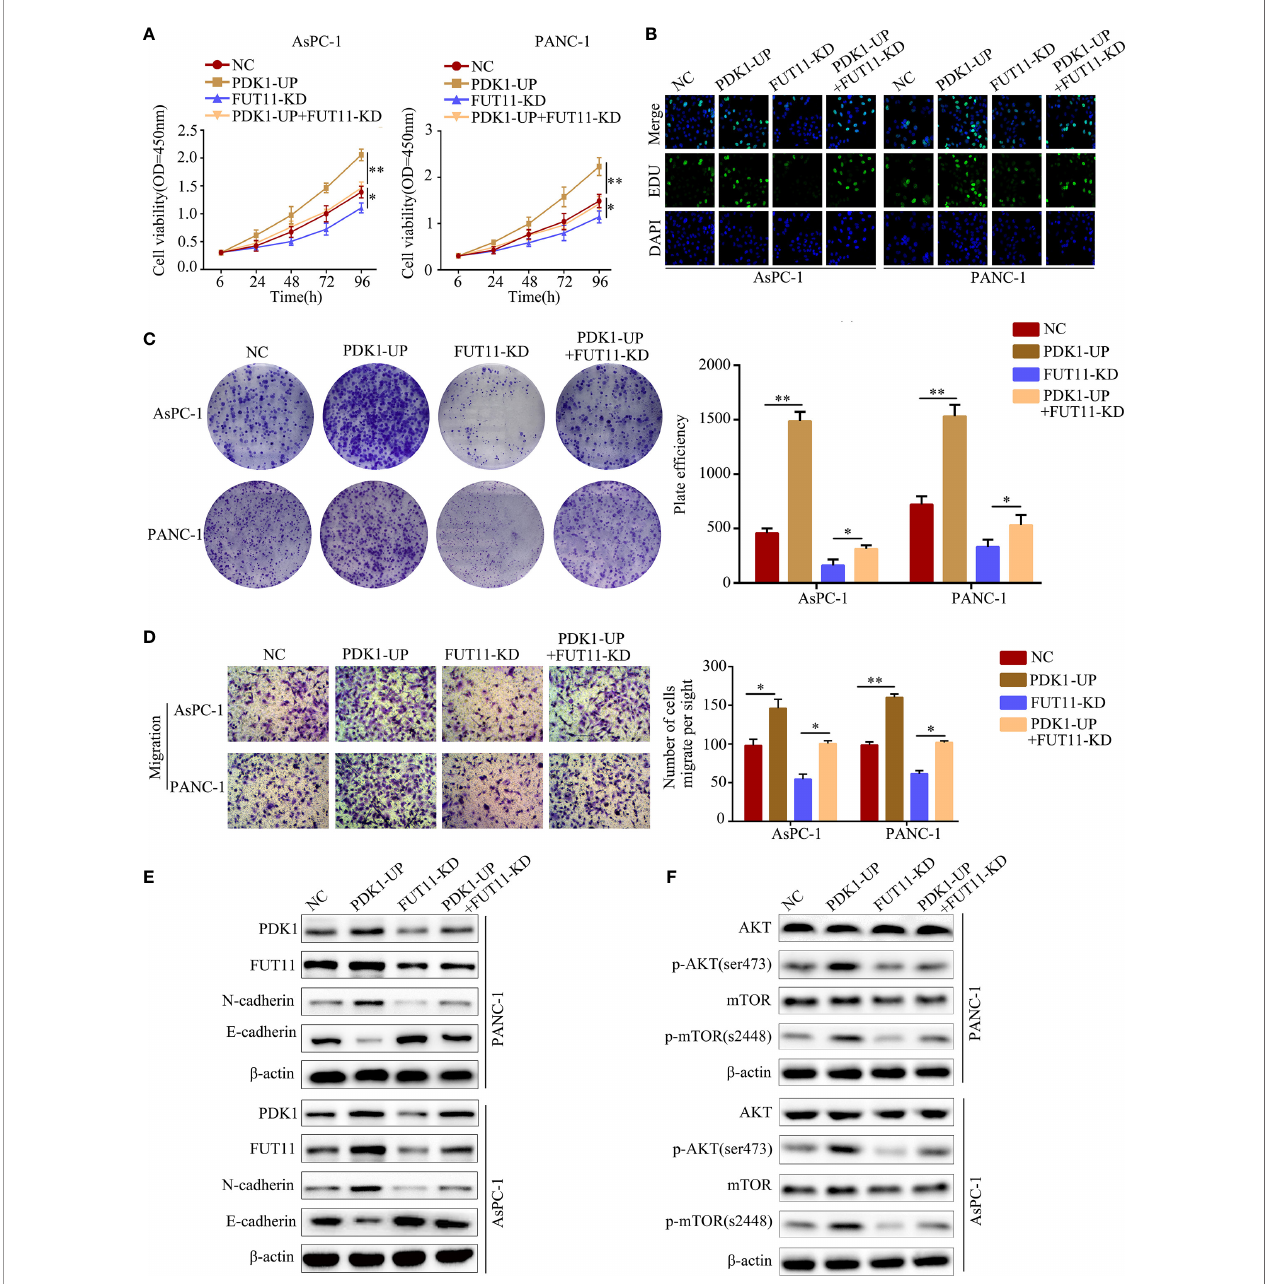
FIGURE 6 | Overexpression of PDK1 reversed the inhibitory effect of FUT11 inhibition on PC cell proliferation and migration. Cells were divided into four groups: negative control group (NC), PDK1 overexpressed group (PDK1-UP), FUT11 knockdown group (FUT11-KD) and PDK1 overexpressed plus FUT11 knockdown group (PDK1-UP + FUT11-KD). All cells were cultured in hypoxia. (A) CCK-8 assay on cell viability of each group. (B) EDU assay on cell proliferation of each group. (C) Colony formation on the colony forming ability of cells in each group. (D) Transwell assay on the cell migratory ability of each group. (E) Western blot on the protein level of FUT11, PDK1, N-cadherin and E-cadherin in each group. (F) Western blot on the protein level of phosphorylated AKT, AKT, phosphorylated mTOR and mTOR in each group. * P < 0.05; ** P <